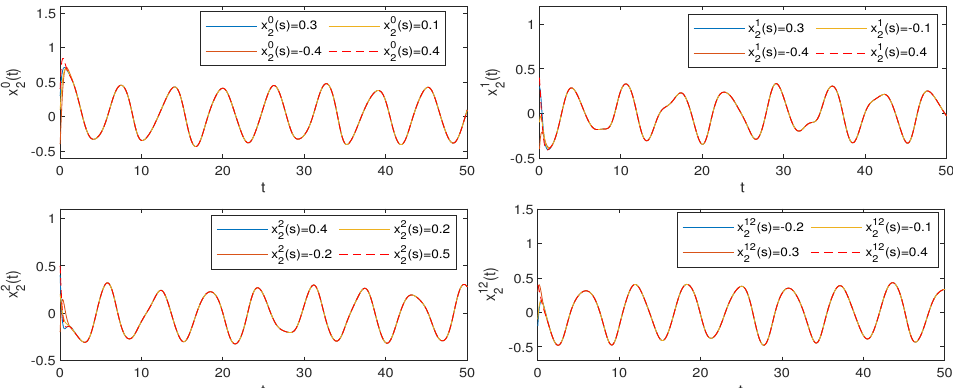
, x 1 , x 2 , x 12 of (1) with different initial values. 1 1 1 1